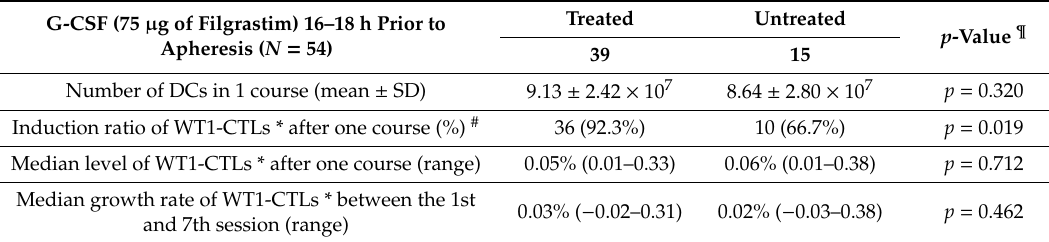
Table 1. The acquisition of Wilms’ tumor 1 (WT1) antigen-specific cytotoxic T cells in patients with human leucocyte antigen class-A*24:02.